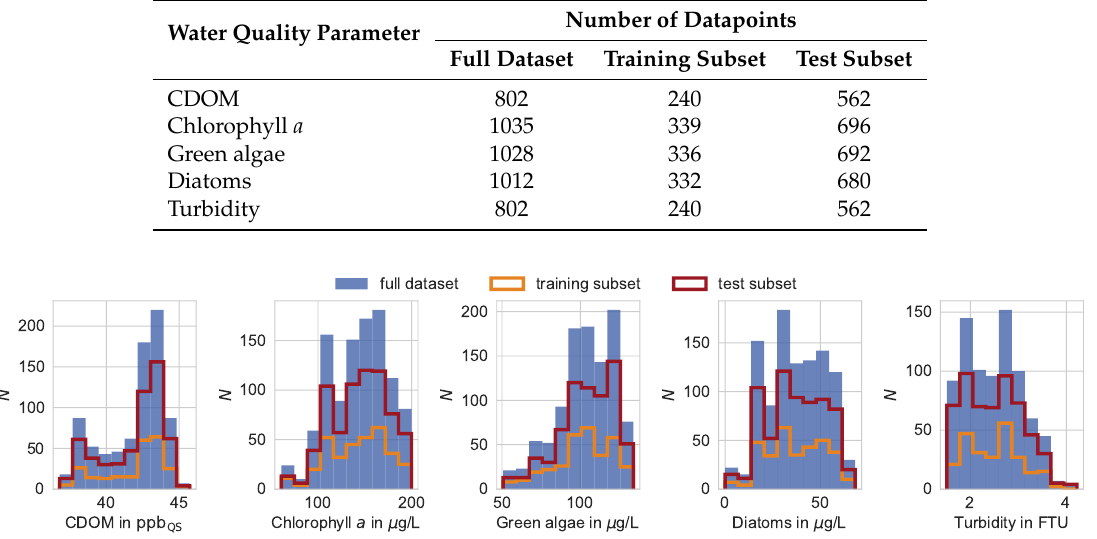
Table 1. Number of datapoints per water quality parameter as the target variable and dataset.